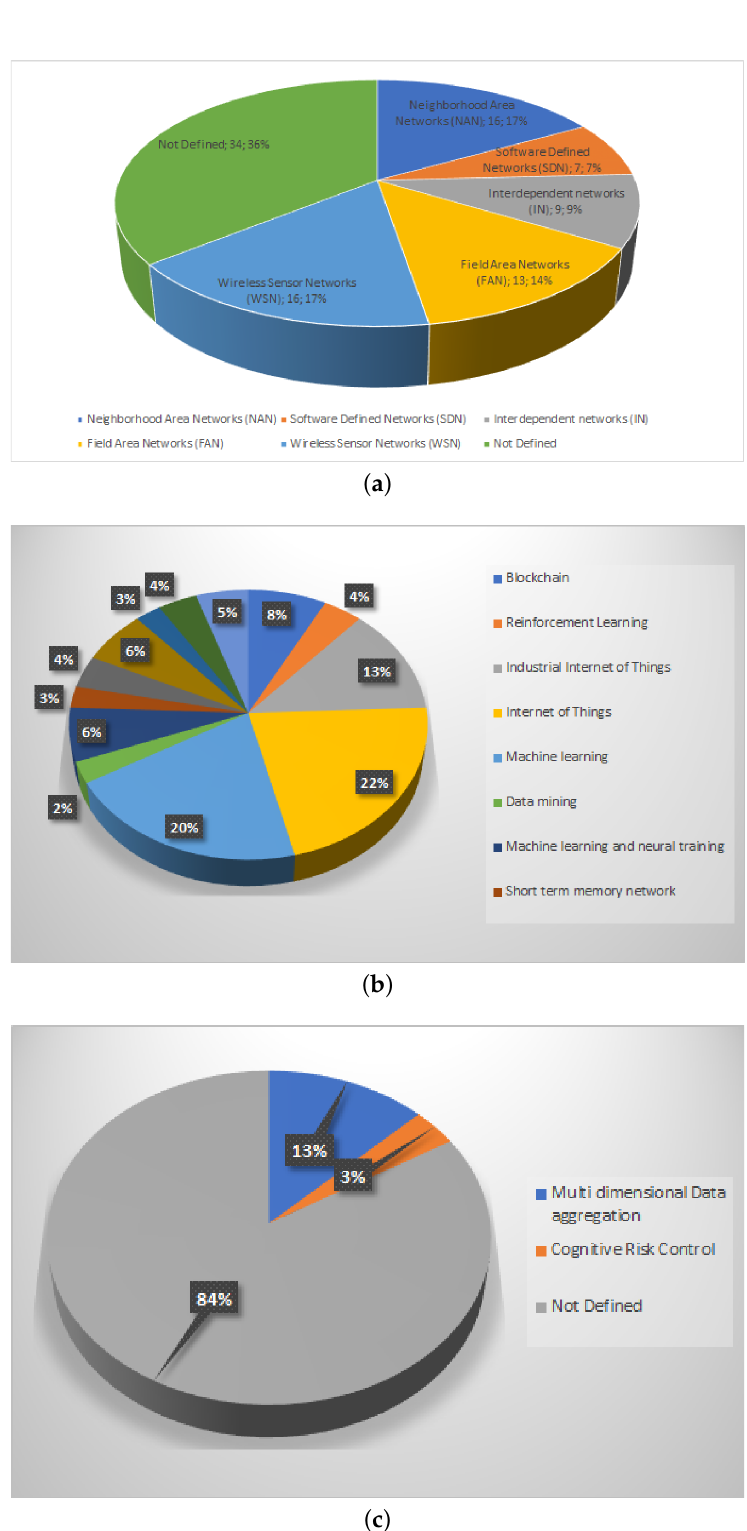
Figure 4. Classification: ( a ) Smart Grid Network Topologies, ( b ) Smart Grid Technologies, and ( c ) Encryption used in Smart Grids.